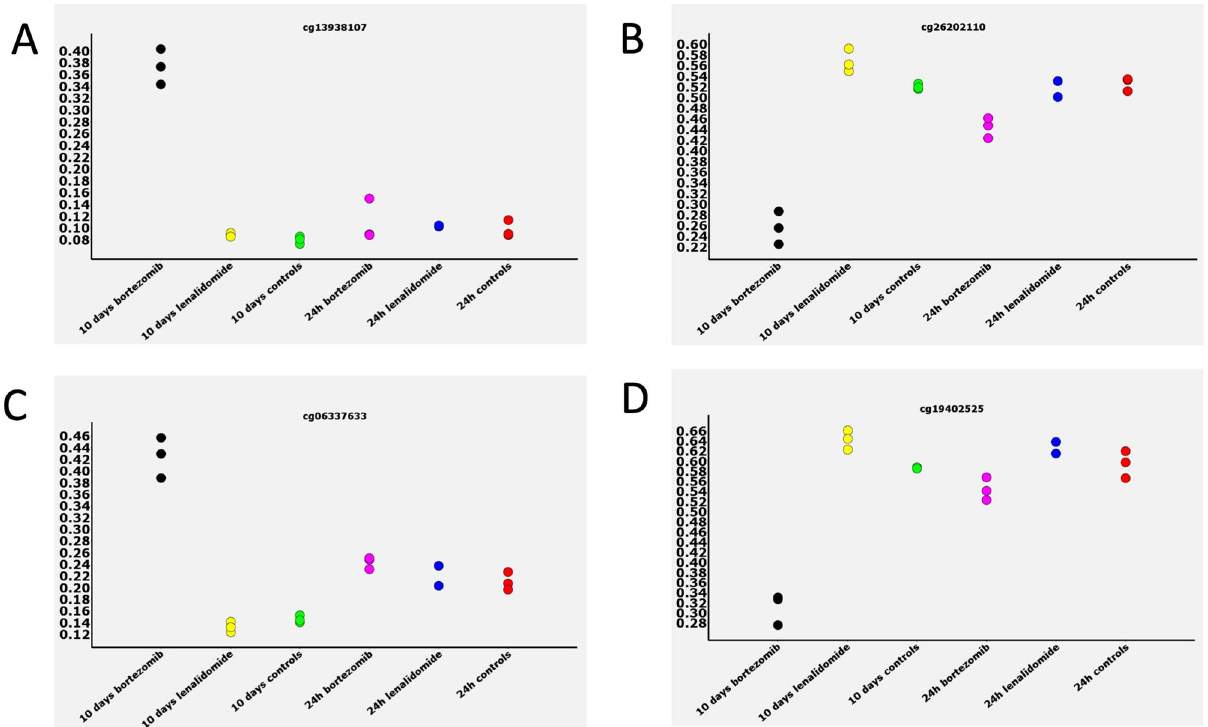
Figure 3. Examples of the methylation changes observed at specific CpG sites across all the treatments and controls. The beta-values representing methylation levels are plotted at the vertical axis and the type of cell at the horizontal axis. Gain of methylation (hypermethylation) in the cells treated with BTZ and recovered from treatment was observed at CpG sites in ( A ) and ( C ), and loss of methylation at CpG sites in ( B ) and ( D